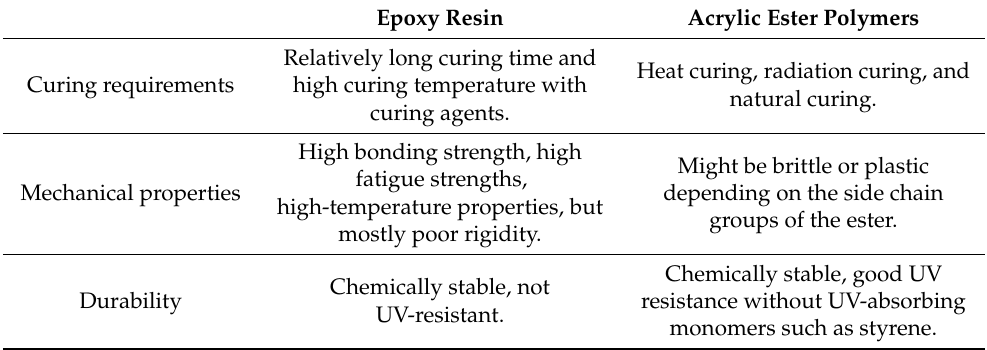
Table 1. Comparison of the epoxy resin and the acrylic ester